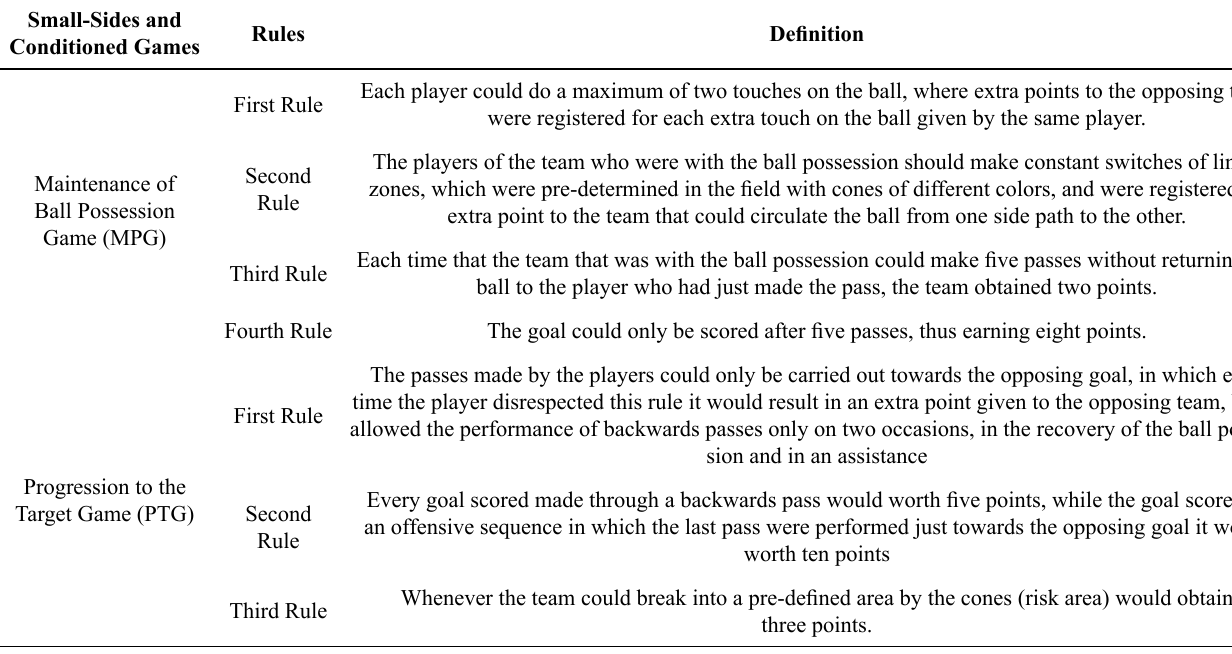
Table 1. Rules included in the different SSCGs used in this study.